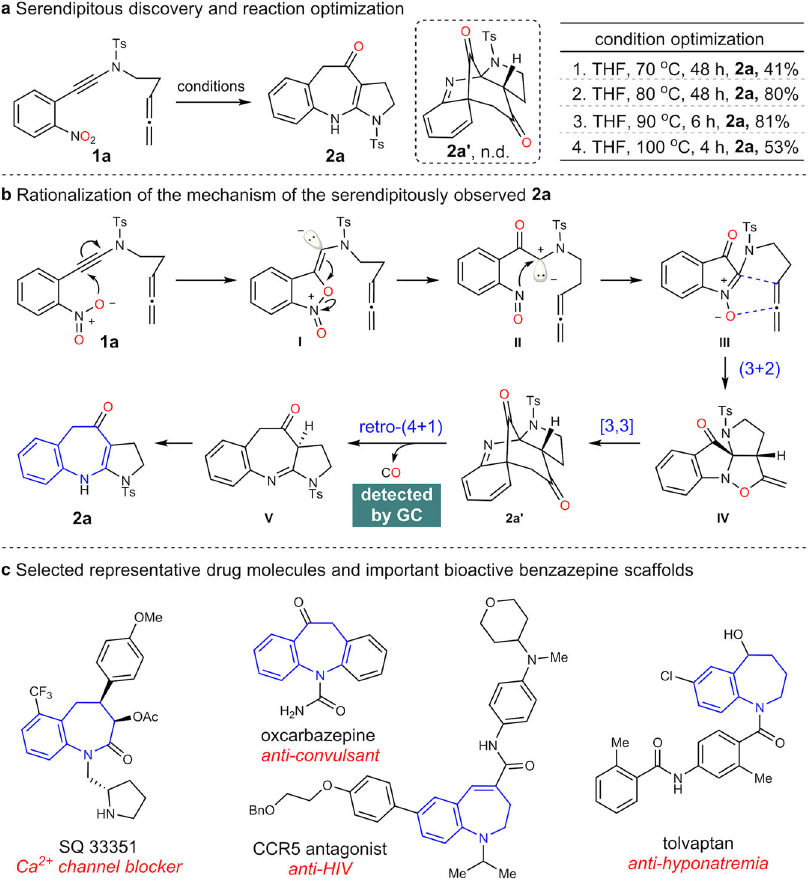
Fig. 2 | Reaction optimization and mechanistic rationalization. a Serendipitous discovery and reaction optimization. b Rationalization of the mechanism of the serendipitously observed 2a . c Selected representative drug molecules and important bioactive benzazepine scaffolds. Ts = p -toluenesulfonyl. Bn =